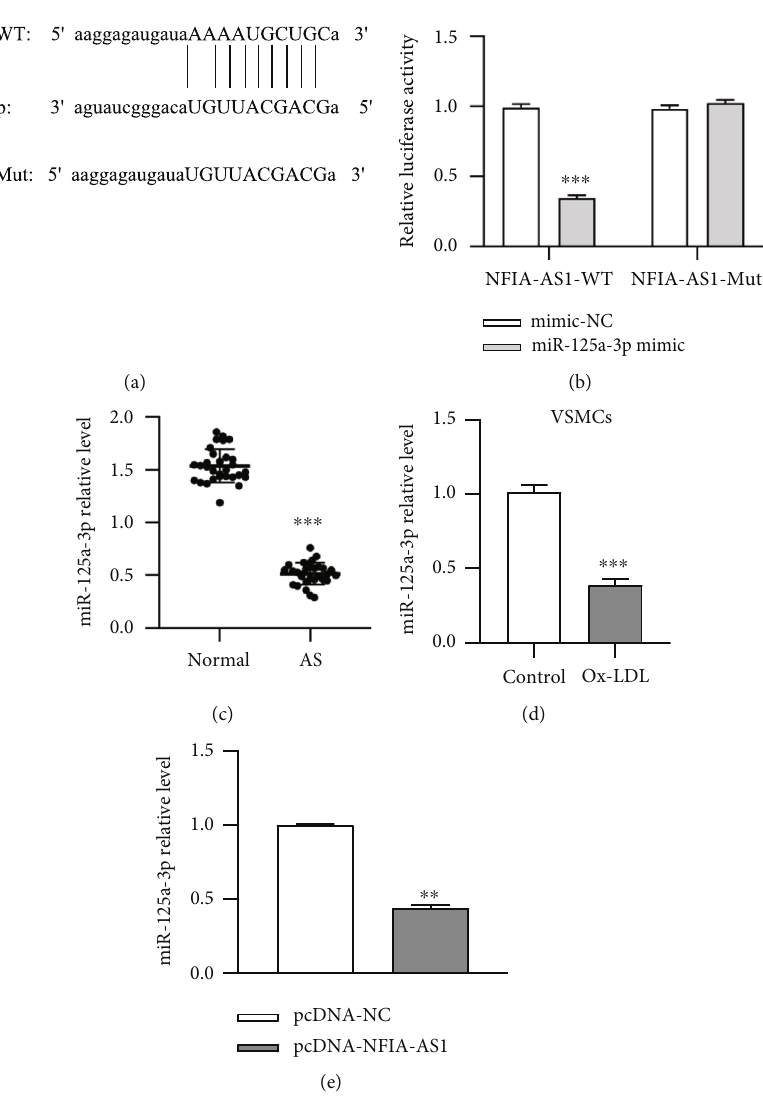
Figure 4: MiR-125a-3p is the target of NFIA-AS1. (a) The binding sites of NFIA-AS1 and miR-125a-3p were predicted by ENCORI. (b) The targeting relationship between NFIA-AS1 and miR-125a-3p was veri fi ed by dual-luciferase reporter assay. MiR-NC or miR-125a-3p was co- transfected into VSMCs with luciferase reporter plasmids containing NFIA-AS1-WT or NFIA-AS1-MUT, and the fl uorescence intensity was detected. The expression of miR-125a-3p in clinical samples (c) and Ox-LDL-induced VSMCs (d) was detected by qRT-PCR. (e) The expression of miR-125a-3p after transfection with pcDNA-NFIA-AS1 was detected by qRT-PCR. ** P < 0 : 01 and *** P < 0 : 001